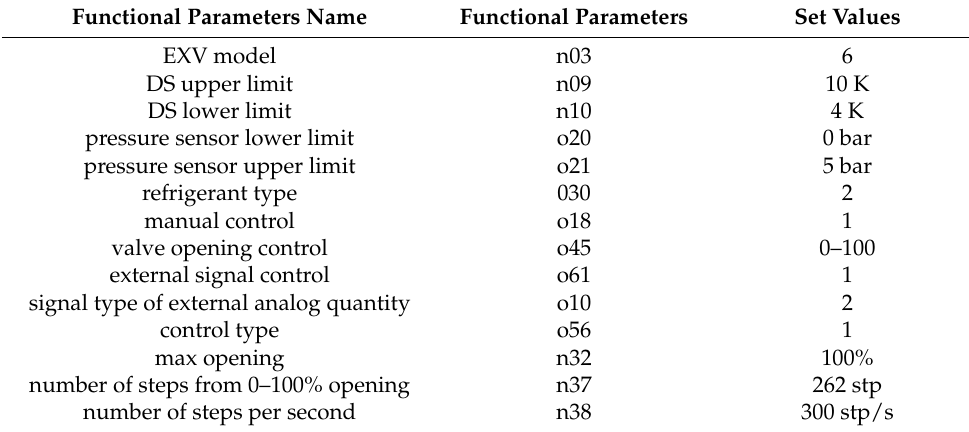
Table 2. Settings of